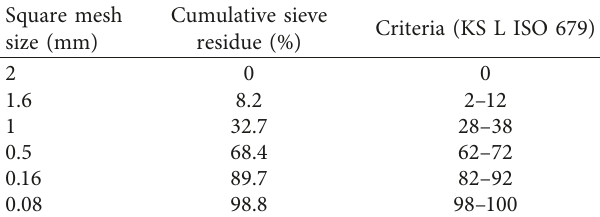
Table 2: Sieve analysis of the sand.